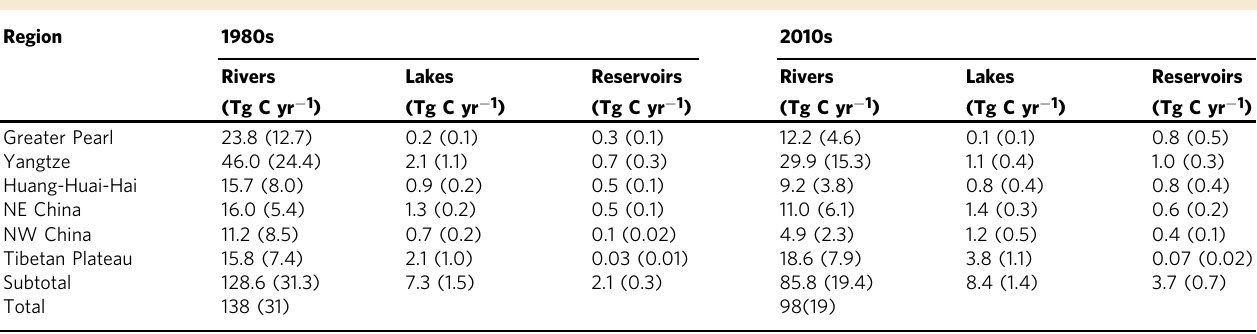
Table 1 Changes in CO 2 ef fl uxes from Chinese inland waters from the 1980s to the 2010s.